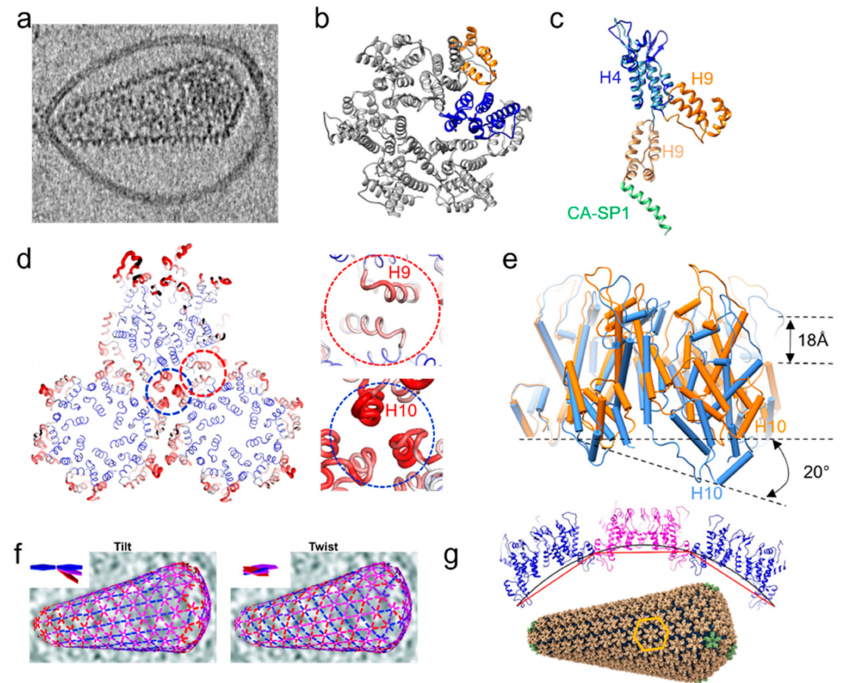
Figure 2. HIV-1 mature capsid organization. ( a ) Tomographic slice of a mature HIV-1 particle with a capsid cone [76]. ( b ) Atomic model of an HIV-1 mature CA hexamer derived from tubular